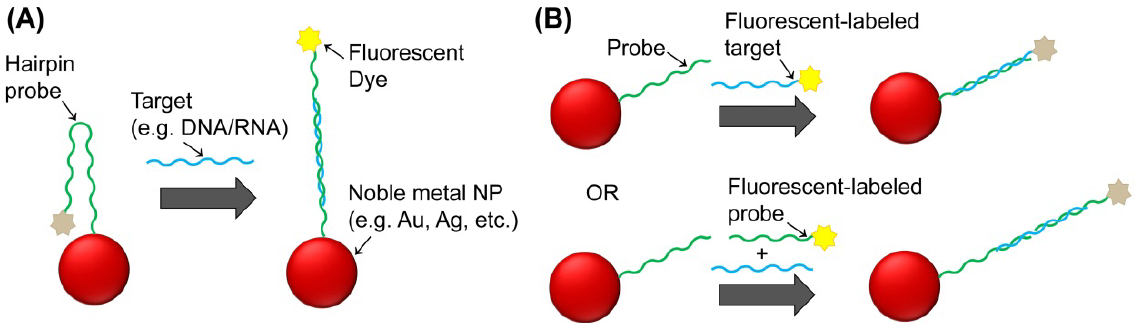
Figure 3. Different approaches for fluorescent-based noble metal NPs